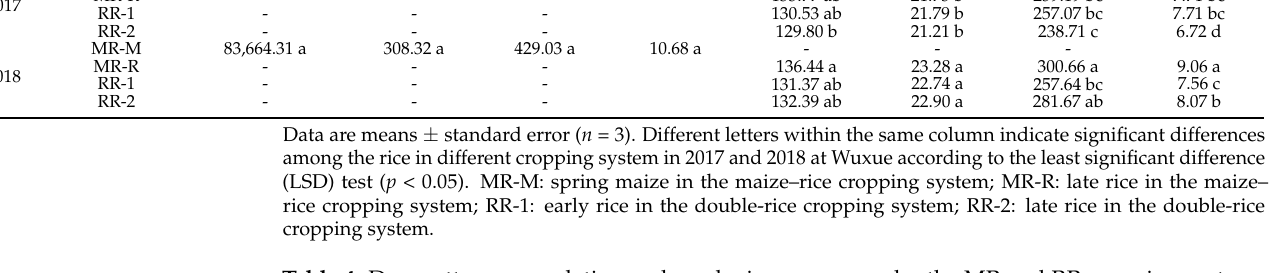
Table 4. Dry matter accumulation and producing energy under the MR and RR cropping systems from 2016 to 2018 at Wuxue and